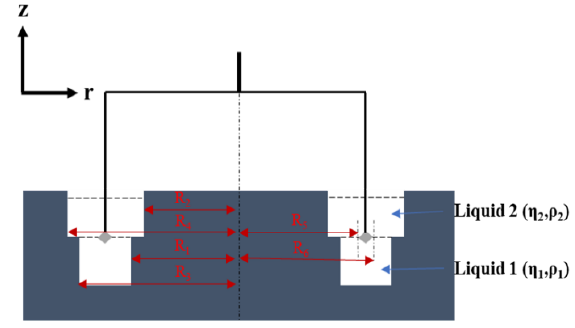
Figure 14. Schematic diagram of the double-wall ring (DWR) device.